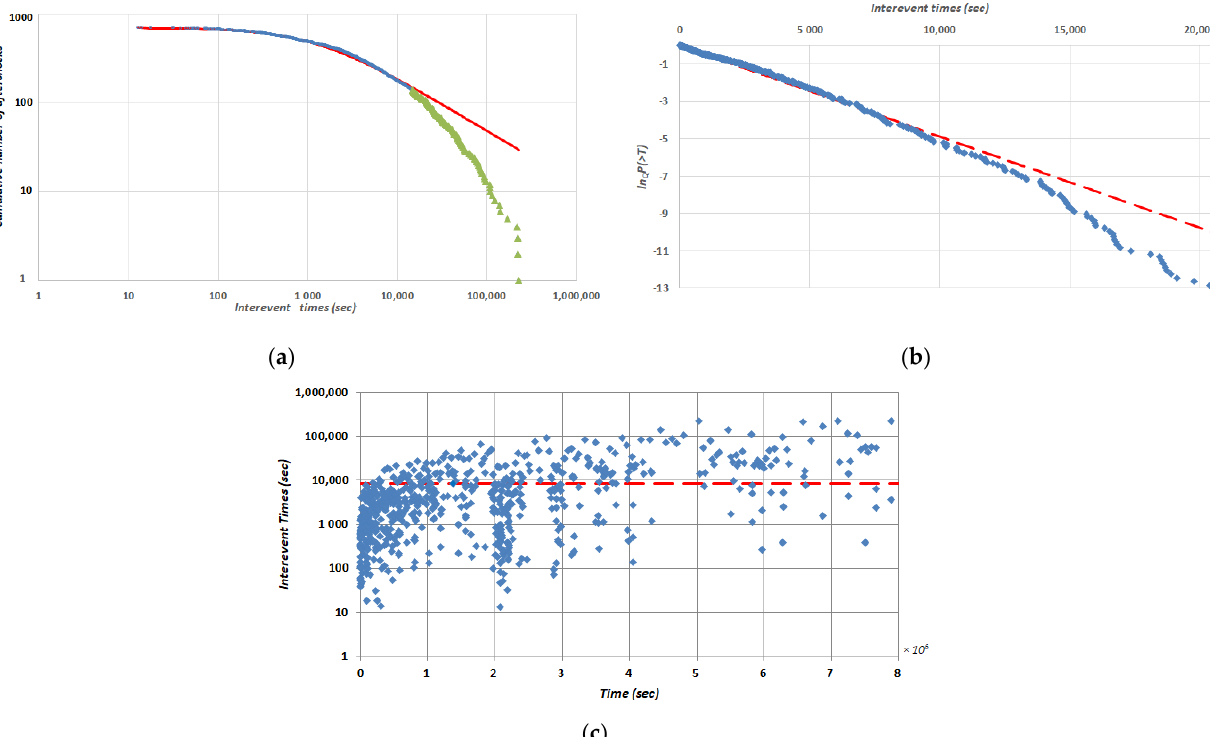
Figure 3. ( a ) The interevent times CDF of the 2021 M w 6.0 Arkalochori earthquake, for the aftershocks with M > M c . The scarlet solid line is the Q -exponential operation with q = 1.62. The change of colors indicates the crossover between the NESP (blue circles) and BG statistics (green triangles). ( b ) The ln Q P (> T ) as a function of interevent times T , where the scarlet line presents the fitting with q = 1.62 and correlation coefficient 0.9953 up to T c . T c value close to 7750 s is suggested by the devia- tion from linearity. ( c ) Interevent time T evolution with time t since the main shock. The red line illustrates the T c value.